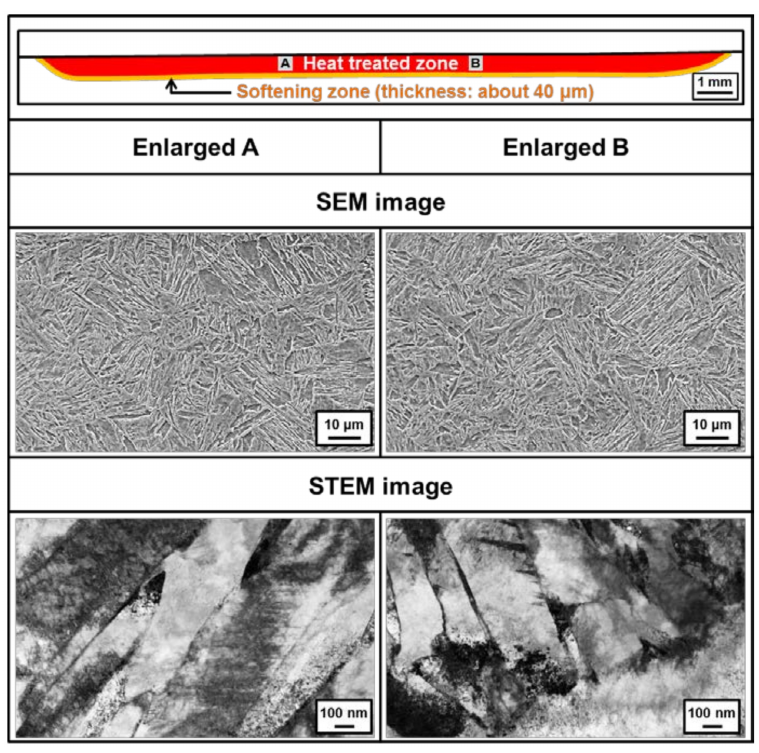
Figure 13. Typical SEM and STEM micrographs of the heat-treated zone of P21 steel after laser-assisted heat treatment at 1473 K.